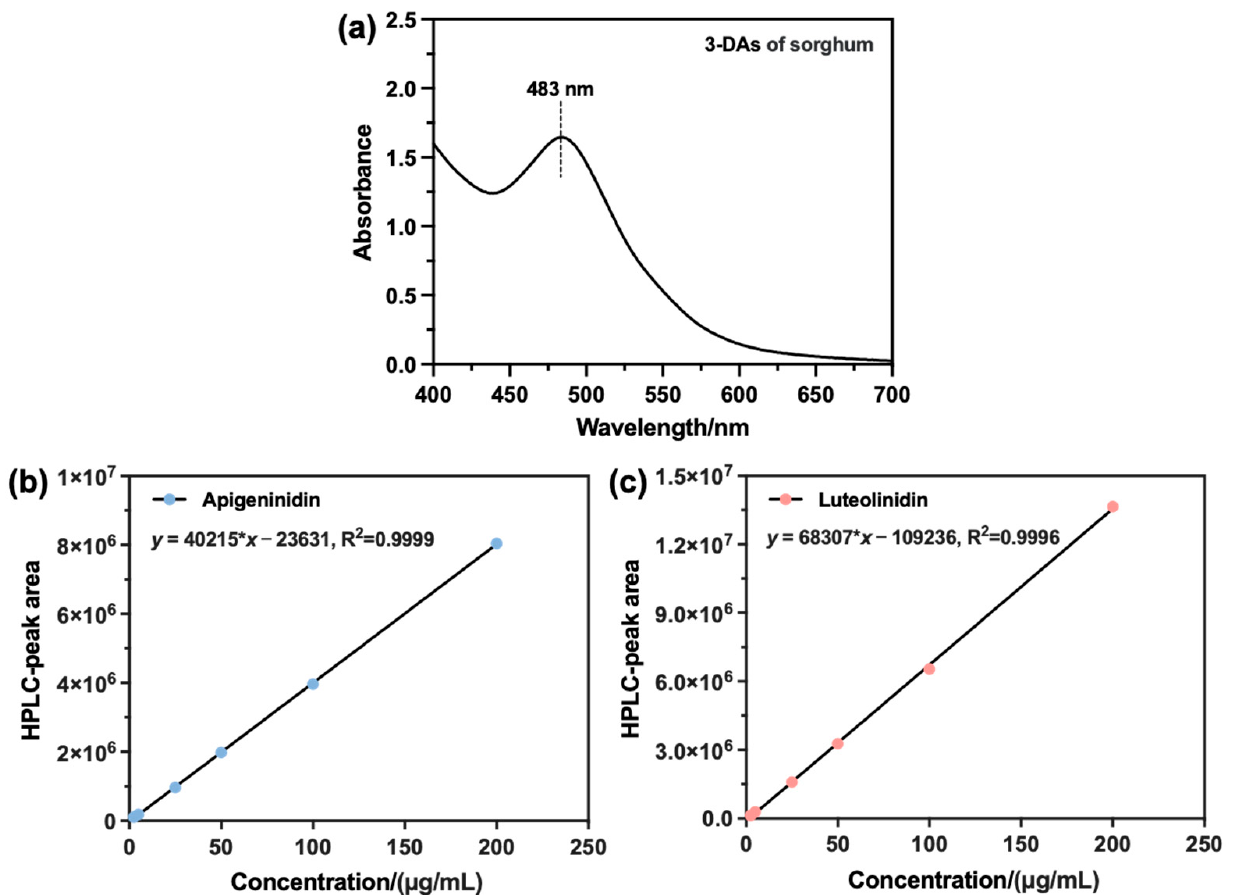
Figure 5. UV-Vis spectrum of the extract ( a ) and the standard curves of Apigeninidin (AE) ( b ) and Luteolinidin (LE) ( c ).